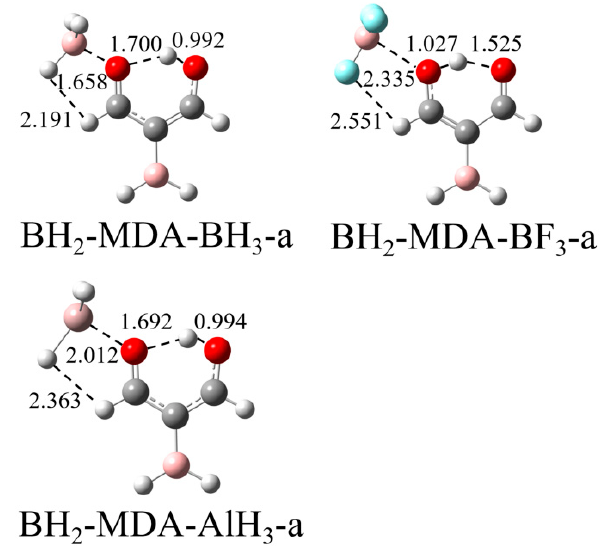
Figure 5. Structures of three a-type complexes substituted by a BH 2 group.